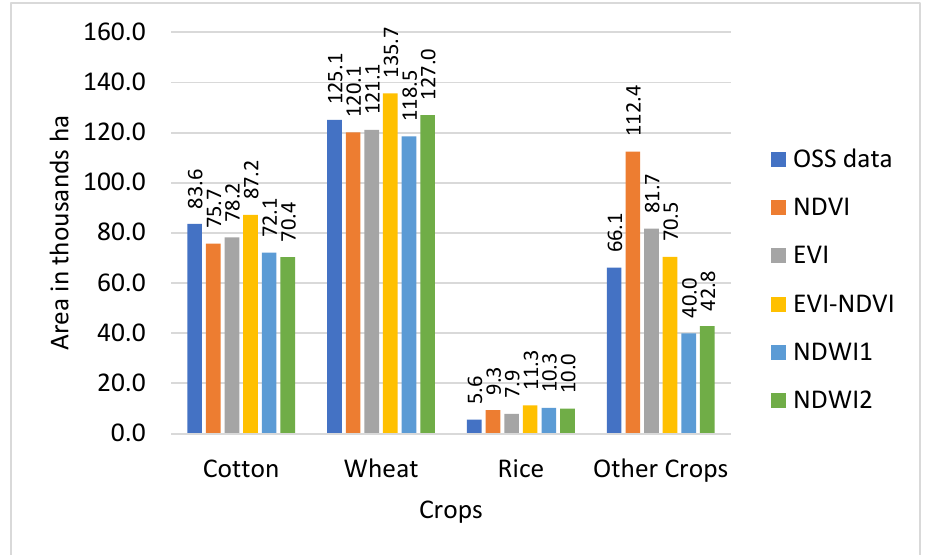
Figure 6. Comparison of classified crop types area with OSS data for RF classifier with S2 sensor.